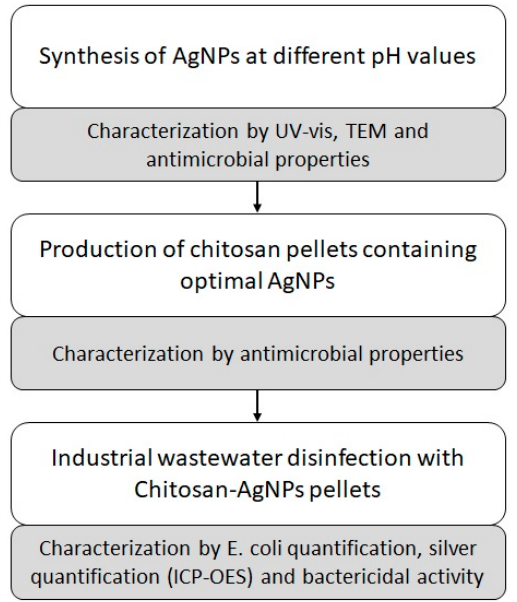
Figure 1. Schematic diagram of the methodology of the study.